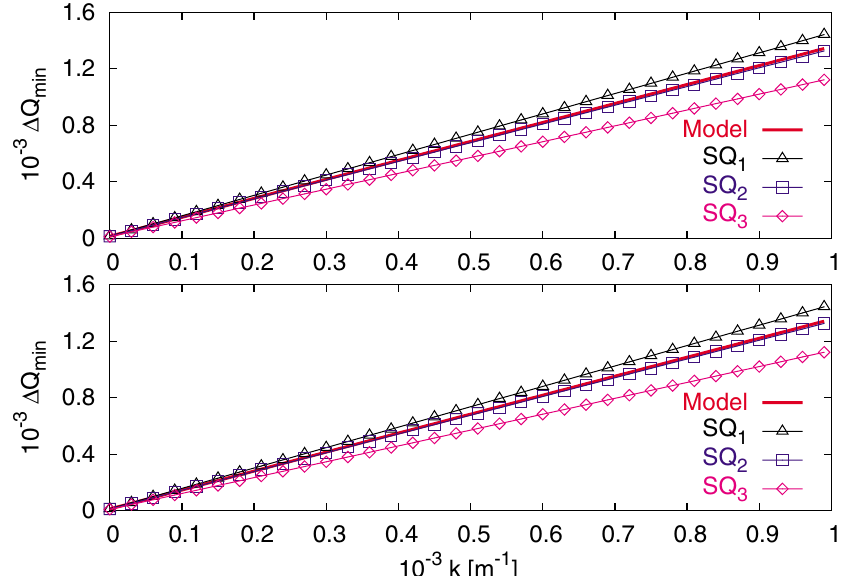
FIG. 9. (Color) Top: (cid:3) Q calculated using the three different values of RDTs at respective locations of skew quadrupoles as a min calculated using three different values of j C j at respective locations of skew quadrupoles as a function of their strength. Bottom: (cid:3) Q min (cid:3) 18 : 226 , Q (cid:3) 17 : 239 function of their strength ( Q x y is calculated with the three values of j C j at the three (cid:3) Q min locations of skew quadrupoles and plotted as a function of